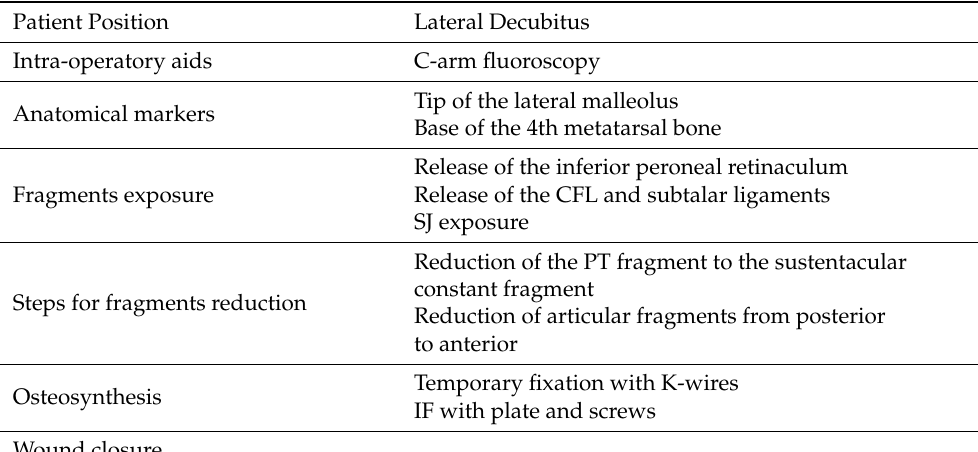
Table 2. Surgical procedure step-by-step.